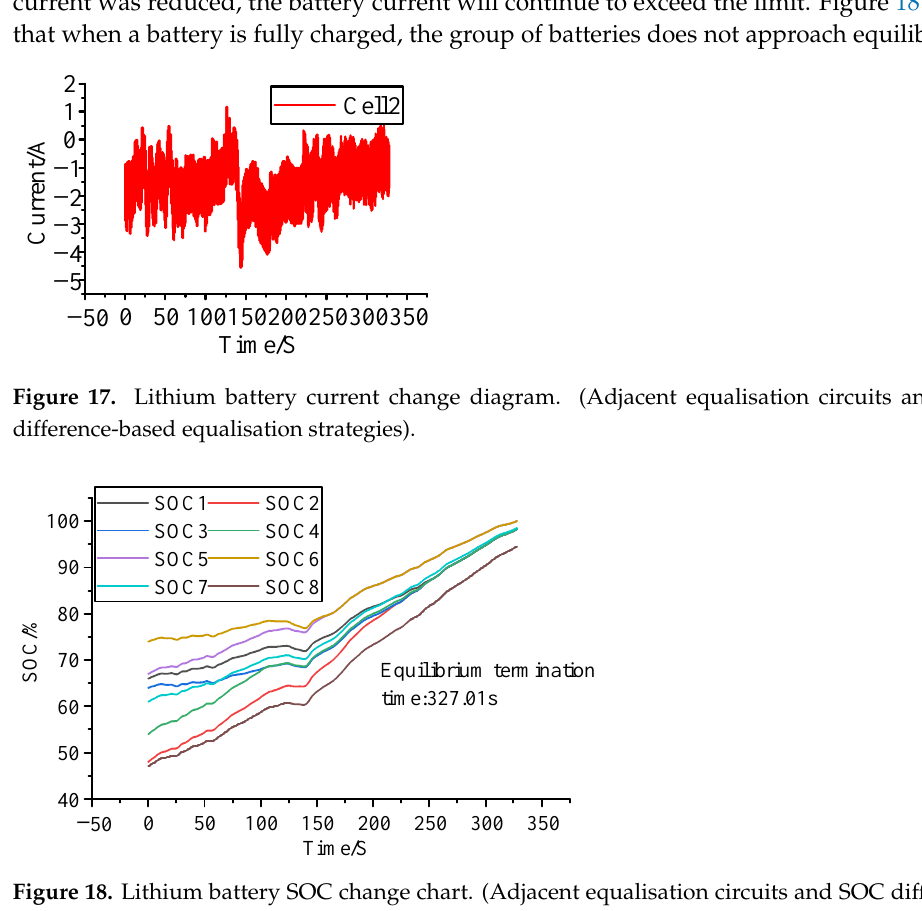
Figure 18. Lithium battery SOC change chart. (Adjacent equalisation circuits and SOC difference- based equalisation strategies)